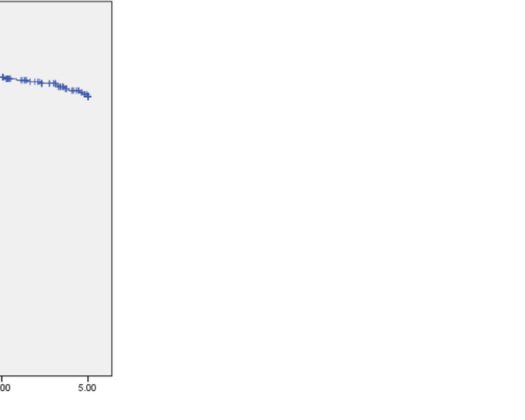
Figure 2. Overall 5-year survival of patients undergoing hand-assisted laparoscopic surgery for cancer (all stages).